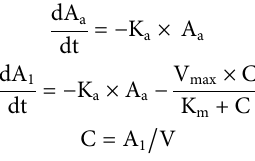
FIGURE2| Theschematicdiagramofpharmacokinetic/pharmacodynamic model of HY-021068.